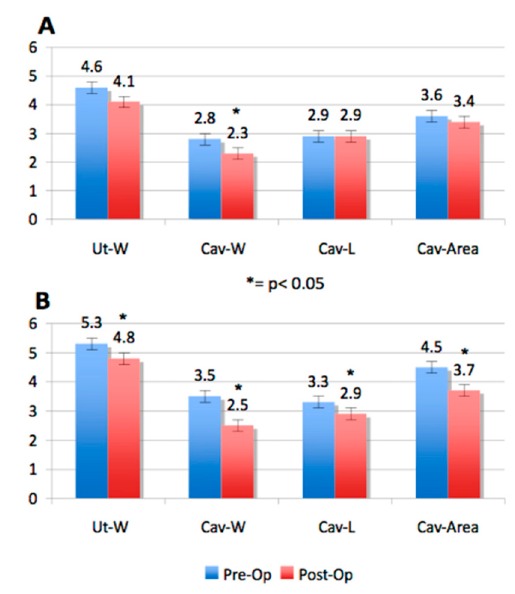
Figure 4. Graphic representation of the pre-operative and post-operative measurements of uterine width, uterine cavity width, length, and area, in subseptate uteri with < 5.9 mm ( A ) and ≥ 5.9 mm ( B ).